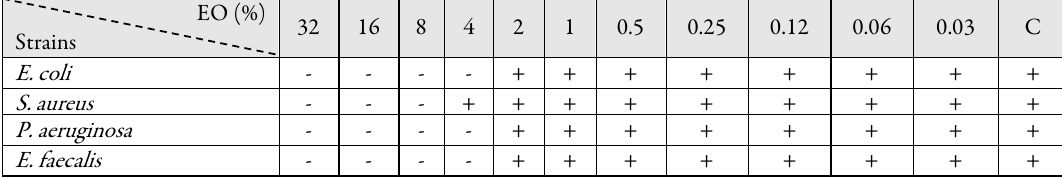
Table 4. MIC of L. angustifolia essential oil against different microbial strains EO (%)